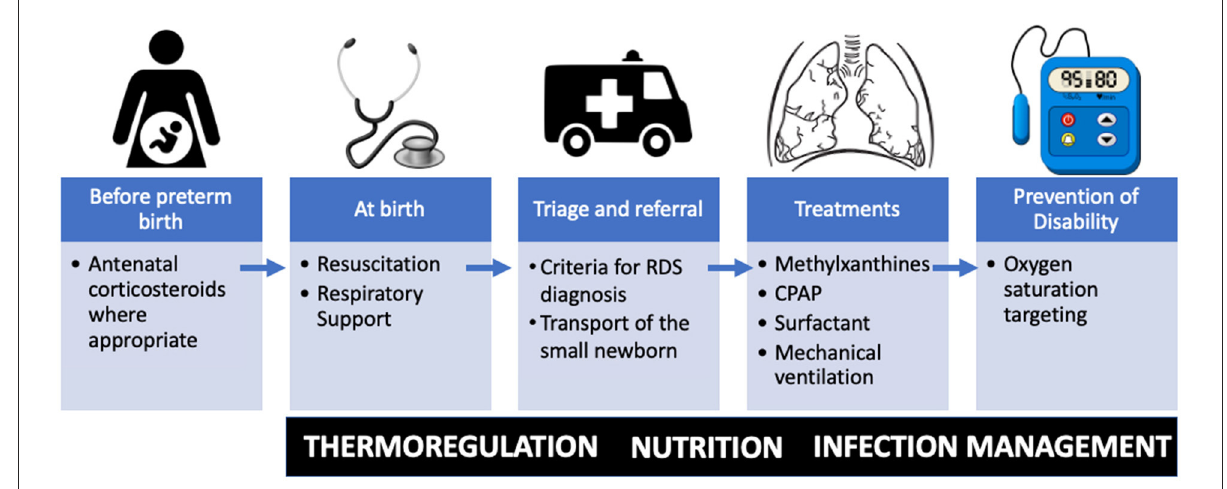
FIGURE1 Essential therapies for respiratory distress syndrome (RDS) in resource limited settings along the time course of preterm birth. Important fundamental premature care includes thermoregulation, nutrition, and management of infection. CPAP, continuous positive airway pressure.